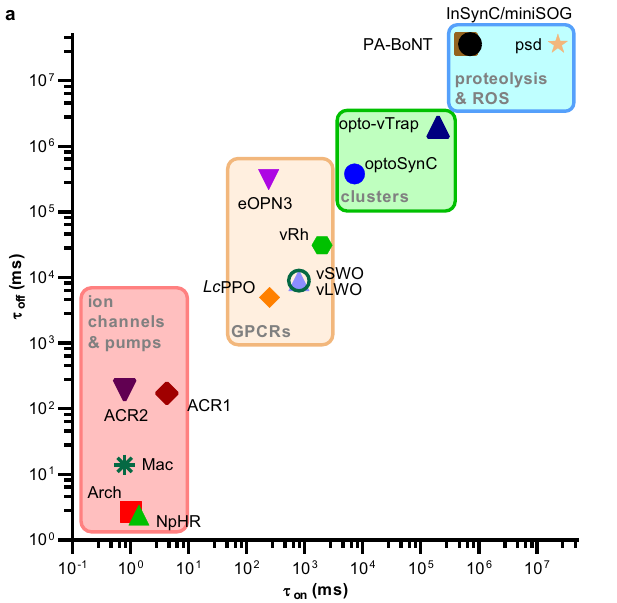
inhibition of locomotion, associated with sustained after-effects. Mean (±s.e.m.) swimming cycles of animals expressing ACR2. Number of individual animals ( n ) across each measured time point and across N =2 independent experiments (ani- mals picked from N independent populations) is indicated as